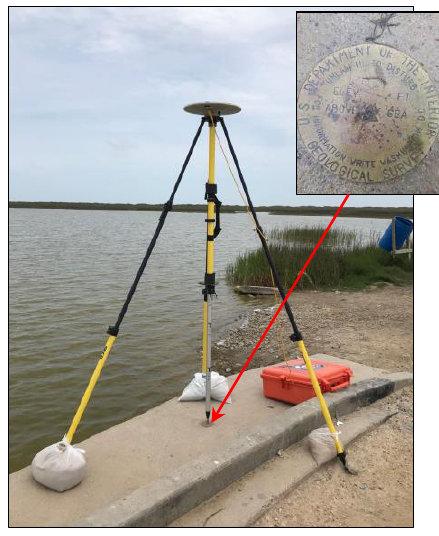
Figure 7. A photo showing the U.S. Geological Survey (USGS) permanent benchmark and the setting up of a reference station for kinematic GPS mapping in the beach area. up of a reference station for kinematic GPS mapping in the beach